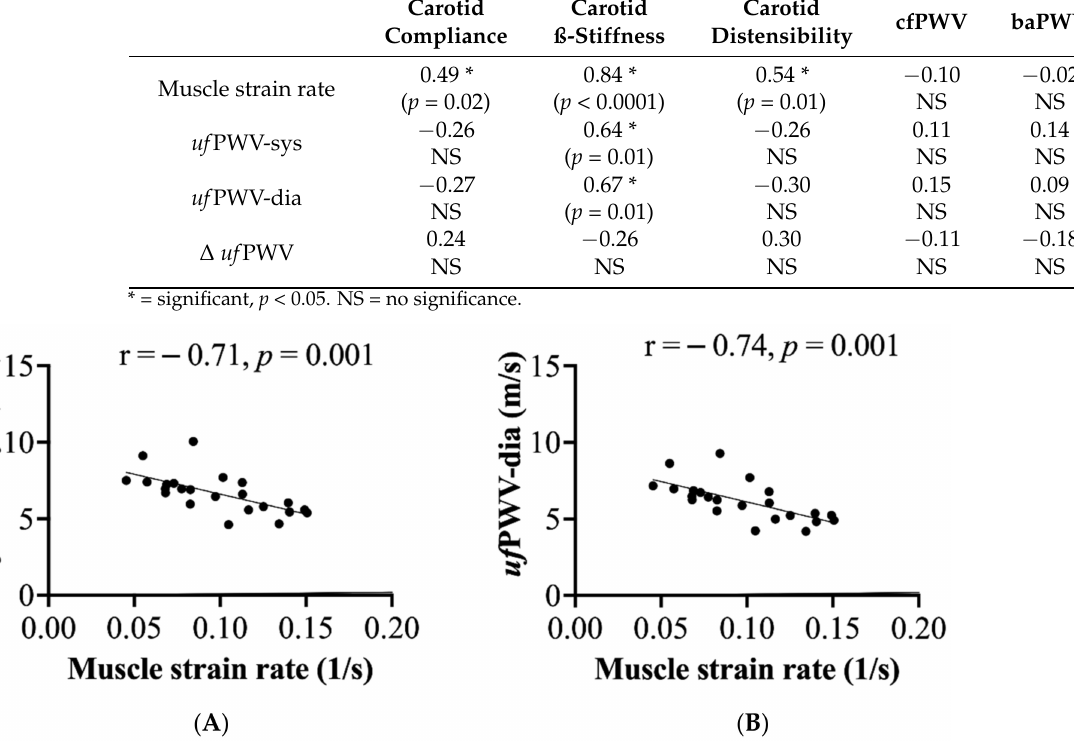
Figure 5. Spearman’s correlation between muscle strain rate and uf PWV at systolic ( A ) and diastolic ( B )